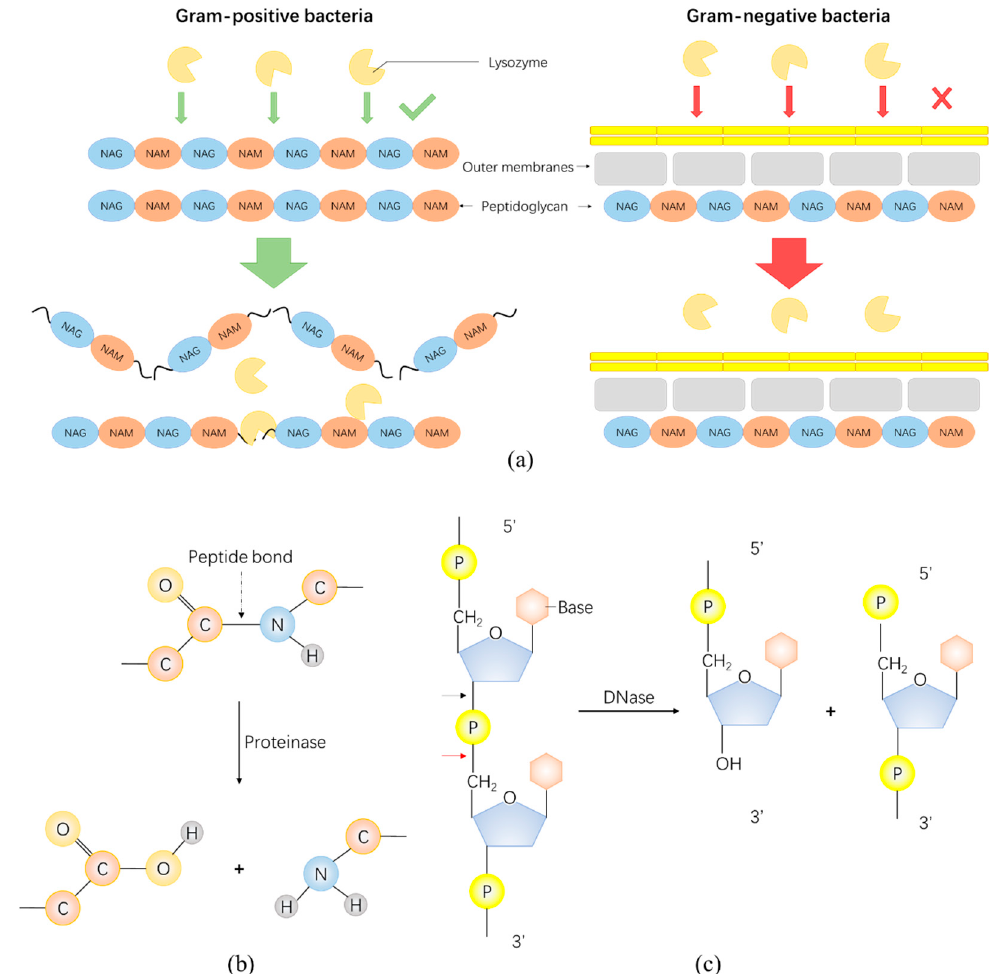
Figure 2. Schematic of the antibacterial mechanism of several typical enzybiotics. ( a ) Schematic of the action of the lysozyme on Gram-positive and Gram-negative bacteria. ( b ) Proteinase can degrade proteins by hydrolyzing peptide bonds. ( c ) Nuclease mainly consists of DNase and RNase, which degrade DNA and RNA, respectively. This figure uses DNase hydrolysis of phosphodiester bound as an example. The black arrow is the hydrolysis site of DNase and the red arrow is the hydrolysis site of RNase (e.g., RNase A family).